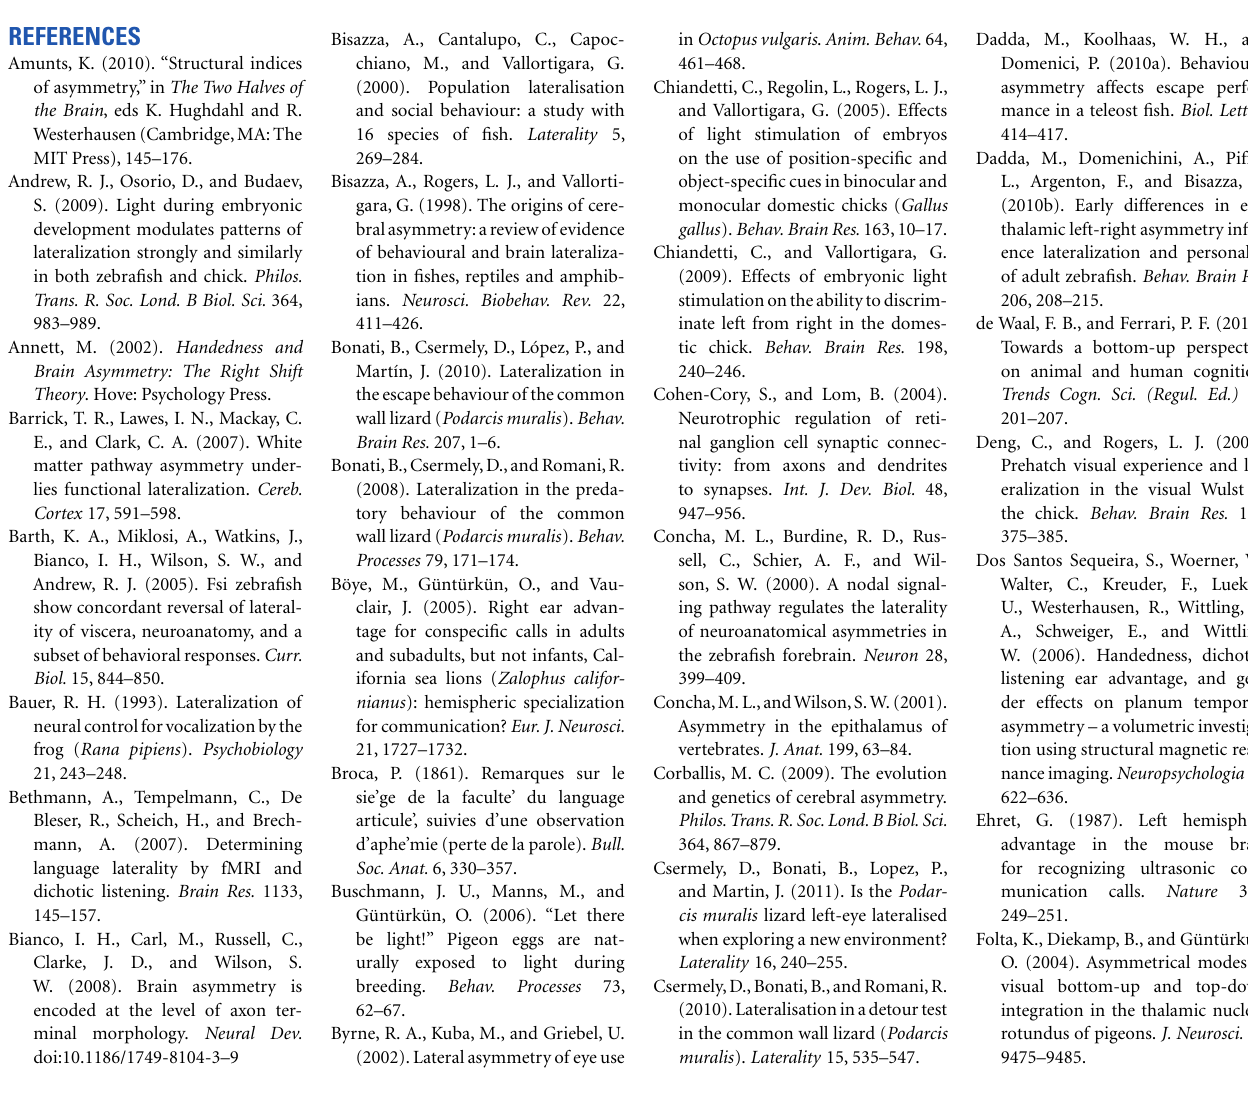
Figure 3 is reprinted from Behavioral Brain Research, 206(2), differences in epithalamic left-right asymmetry influence later- alization and personality of adult zebrafish. 208–215, Copyright (2010), with permission from Elsevier. We like to thank Dr. Marco Dadda for providing this figure to